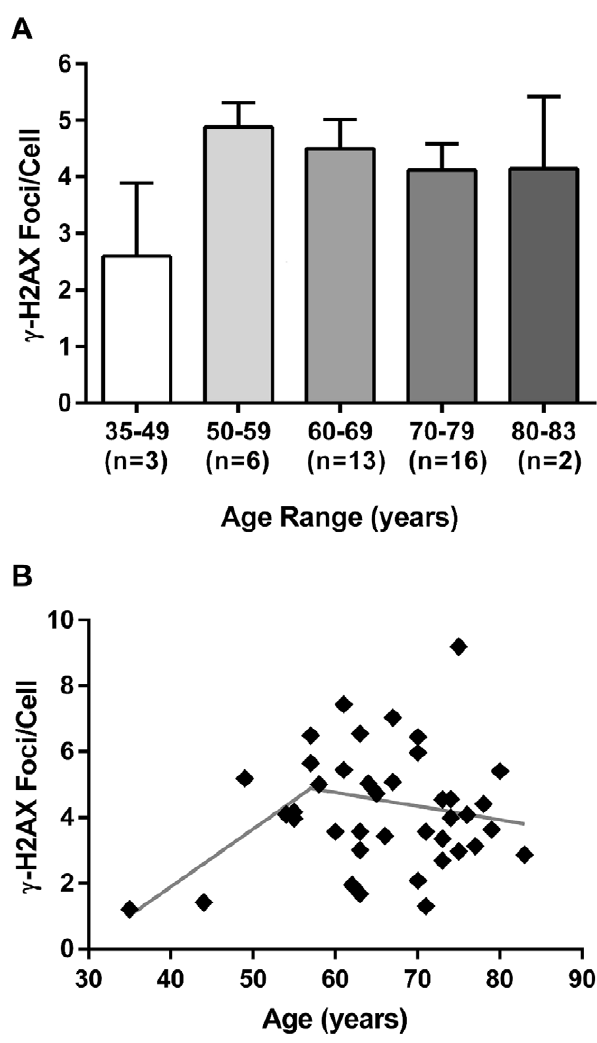
Figure 2. Distribution of c -H2AX foci/cell in human leukaphe- resis-derived mononuclear cells by age. ( A ) c -H2AX foci in human leukapheresis-derived mononuclear cells, stratified by age subgroups. Average c -H2AX foci/cell is shown for each age subgroup. ( B ) Scatter plot of c -H2AX foci/cell in human leukapheresis-derived mononuclear cells by age. Dotted line is best fit showing change-point (age 57) as determined by piecewise linear regression.